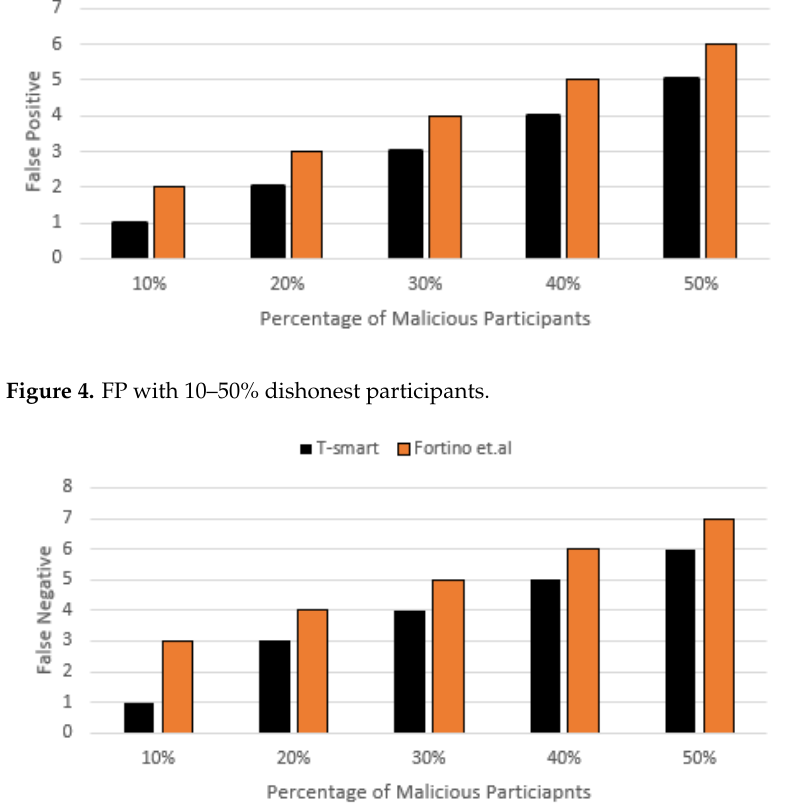
Figure 5. FN with 10–50% dishonest